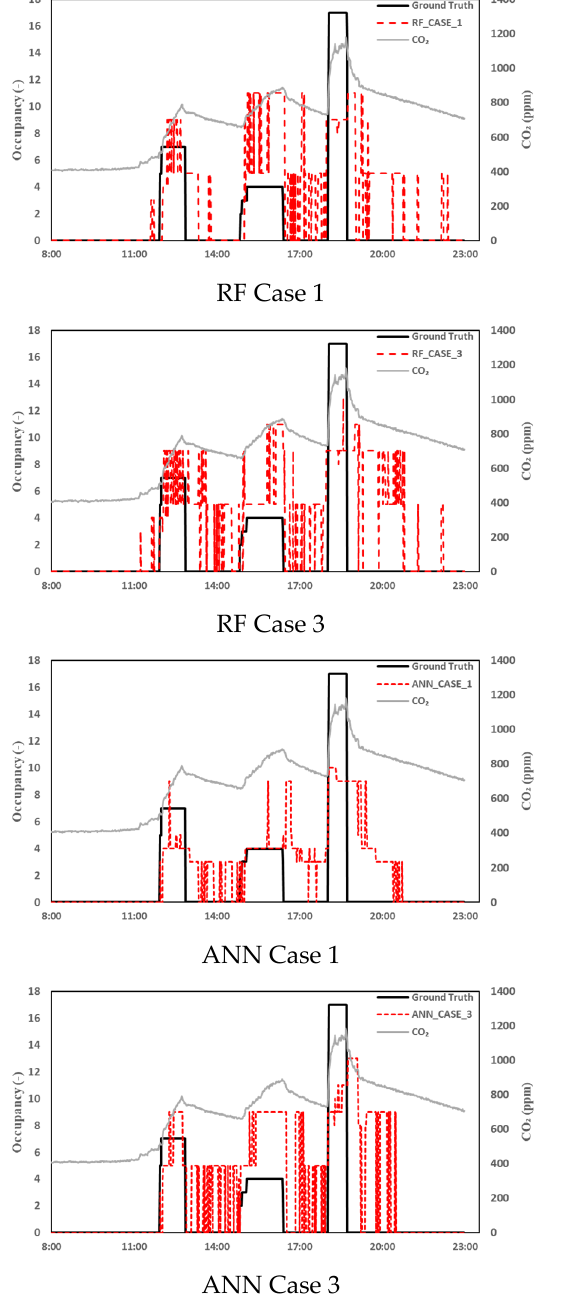
Figure 6. A comparison of the ground truth and estimated occupancy on 11/7.